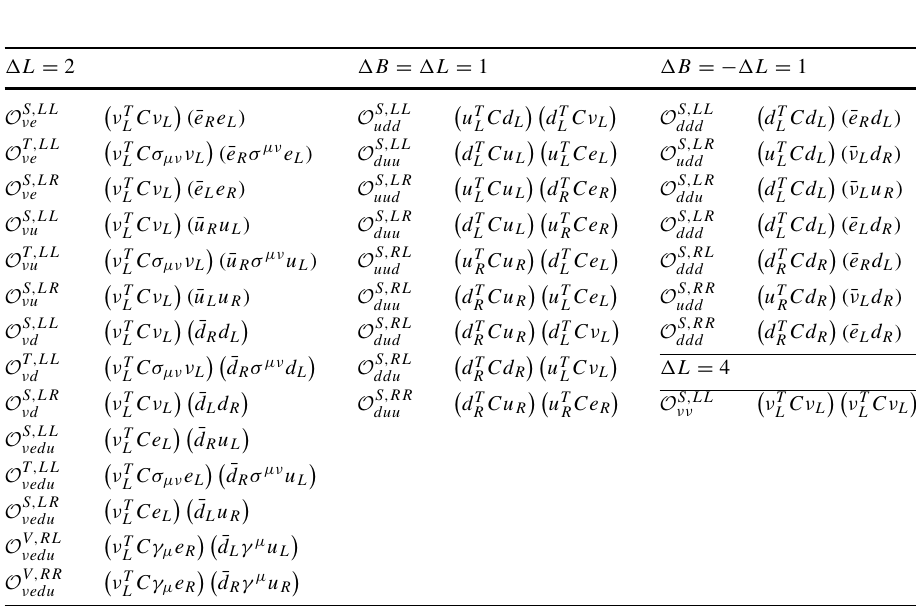
Table 13 LEFT Baryon and/or Lepton number violating dimension-six operators. We use C to denote the Dirac charge conjugation